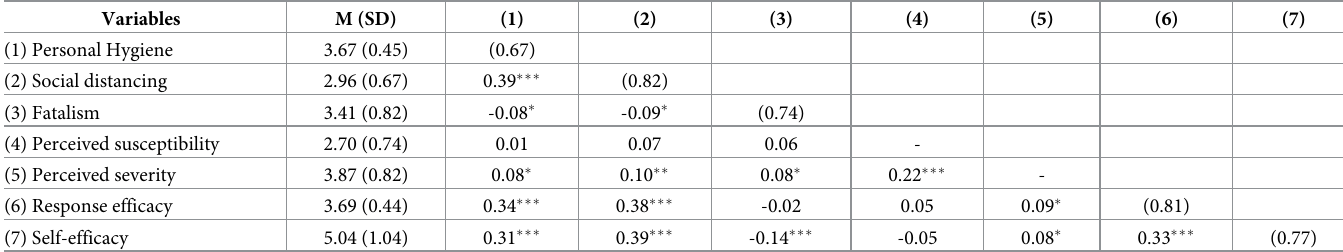
Table 2. Mean values, standard deviations, Cronbach’ s alpha, and Pearson correlations between the variables in regressions.